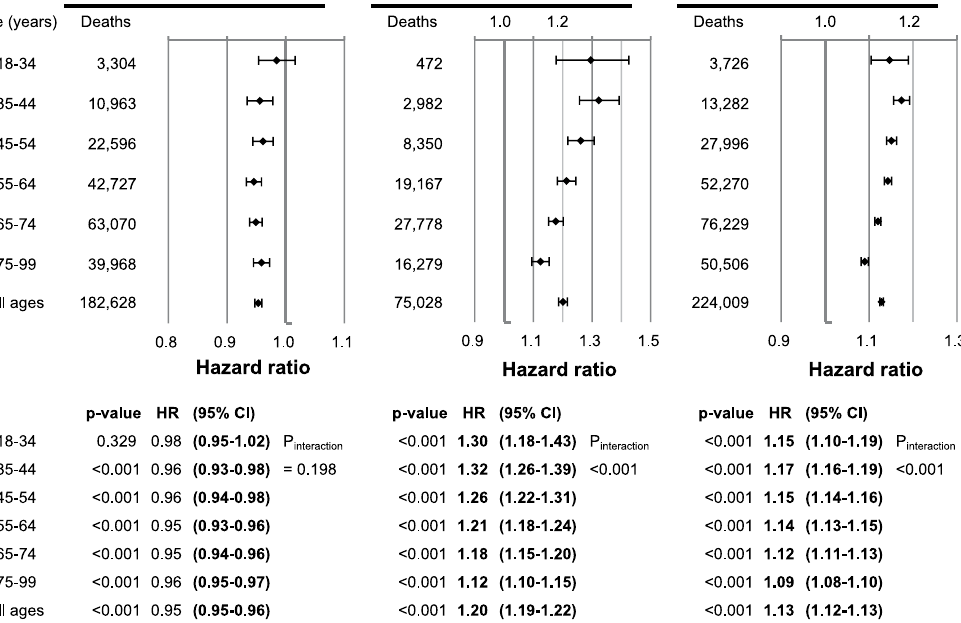
Figure 4. Hazard ratios * per each 18 mg/dL (1 mmol/L) increase in fasting serum glucose (FSG), according to FSG range and age. * Hazard ratios and 95% confidence intervals were calculated using the same method as in Fig. 2. To convert glucose from mg/dL to mmol/L, multiply by